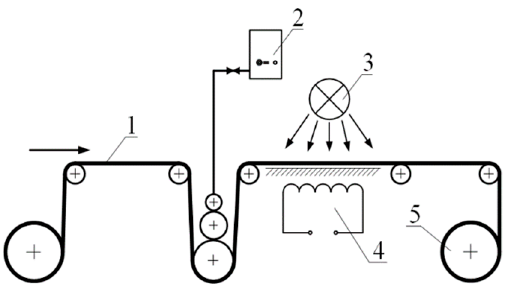
Figure 2. Schematics of tetrahydrofuran solution application, drying and storage in a roll. 1—film, 2—container with solution, 3—fan, 4—thermostat, 5—roll.